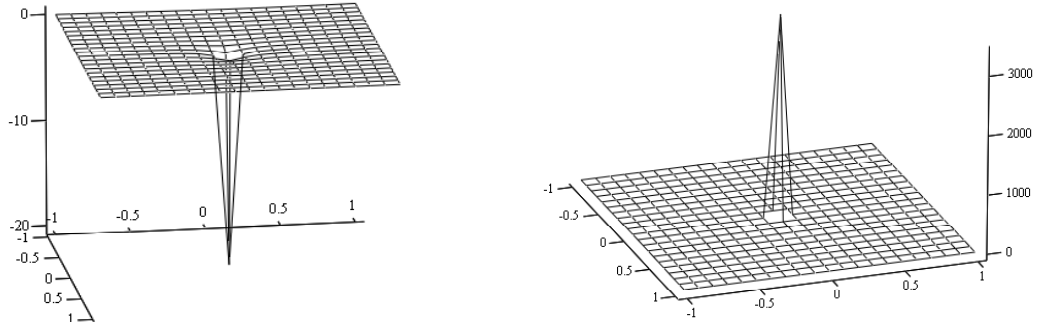
Figure 2. Integrand variations of ( a ) I i and ( b ) K i for a typical